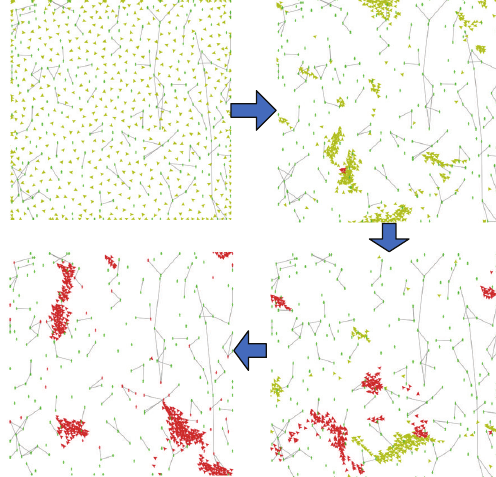
Figure 5: The processes of H7N9 transmission.